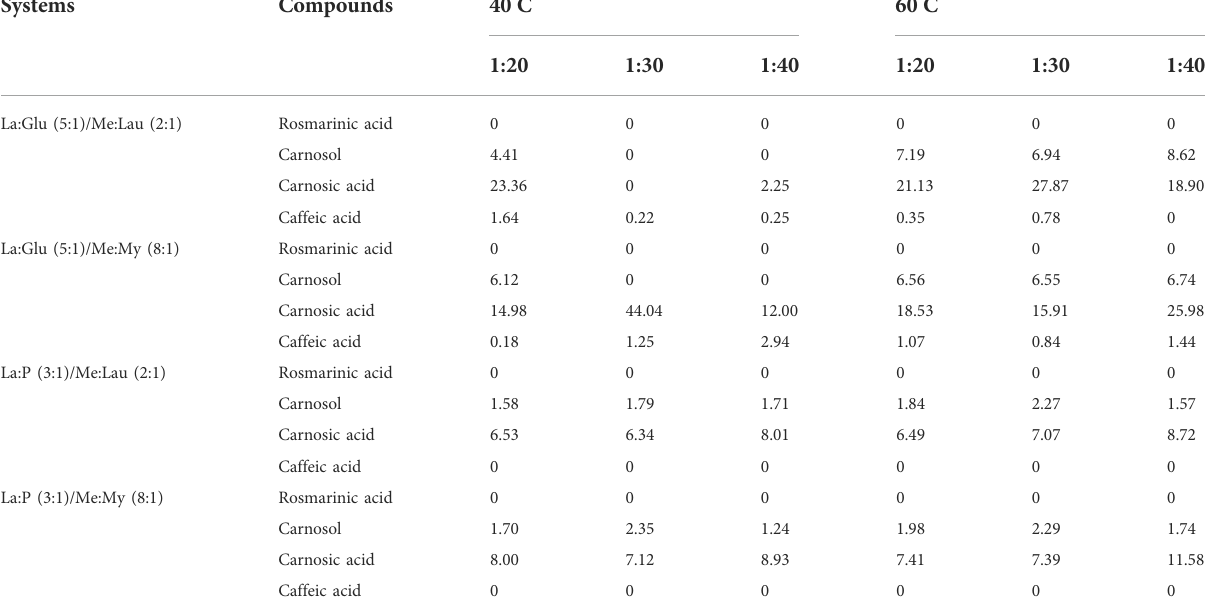
TABLE 7 Partition coef fi cient ( K ) of rosmarinic, acid, carnosol, carnosic acid, and caffeic acid in each biphasic system under different ratio conditions (1:20, 1:30, and 1:40) and temperatures (40 ° C and 60 ° C). Systems Compounds